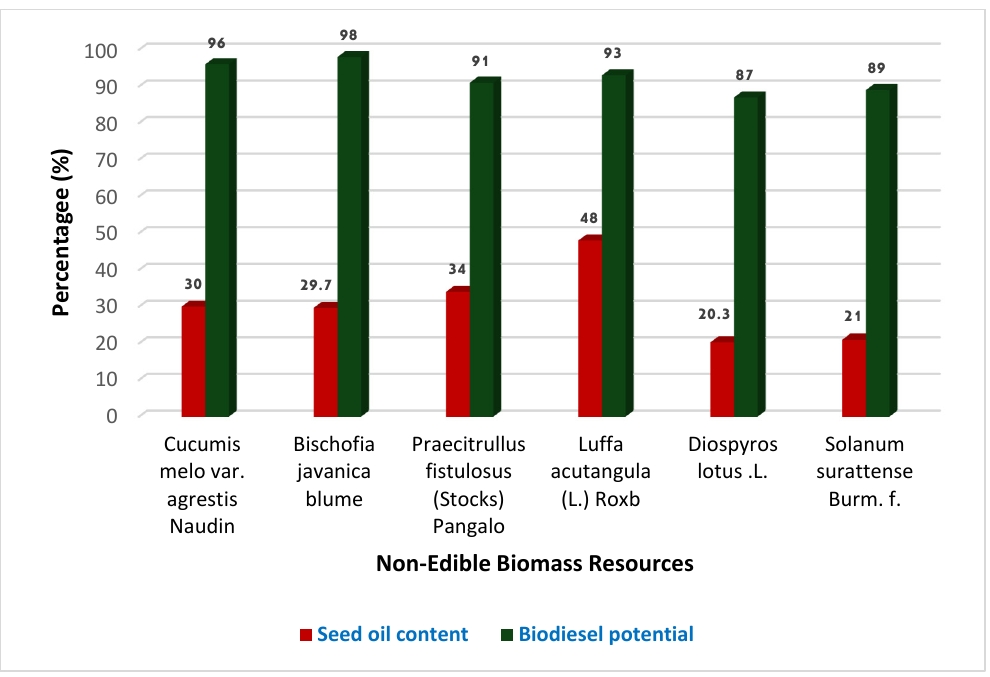
Figure 7. Seed oil content and biodiesel potential of non-edible biomass resources (bioenergy crops).